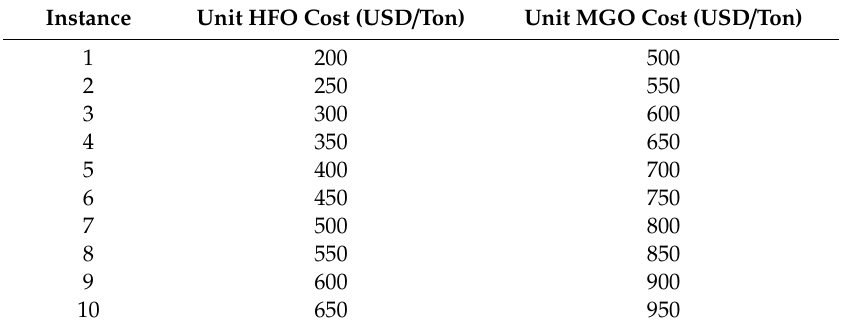
Table 2. The considered unit fuel cost values for the generated problem